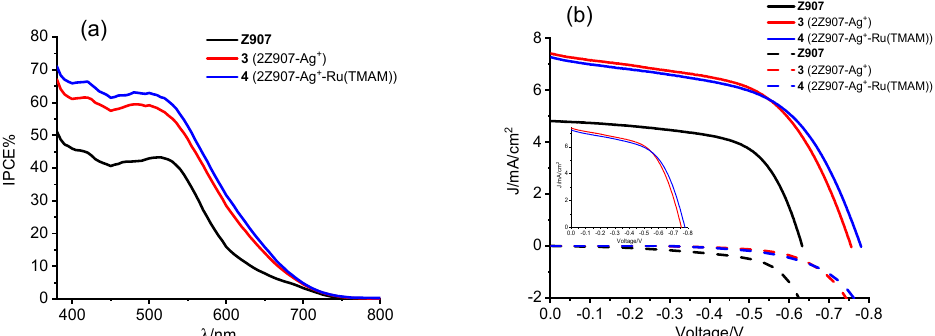
Figure 9. ( a ) IPCE spectra and ( b ) JV curves for Z907 (black line), 3 (2Z907-Ag + ) (red line) and 4 (2Z907-Ag + -Ru(TMAM)) (blue line) recorded under 0.1 W/cm 2 AM 1.5 G illumination.